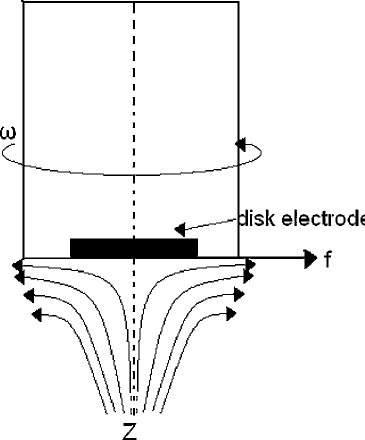
FIG. 1. Solution movement caused by rotation of an RDE [8].